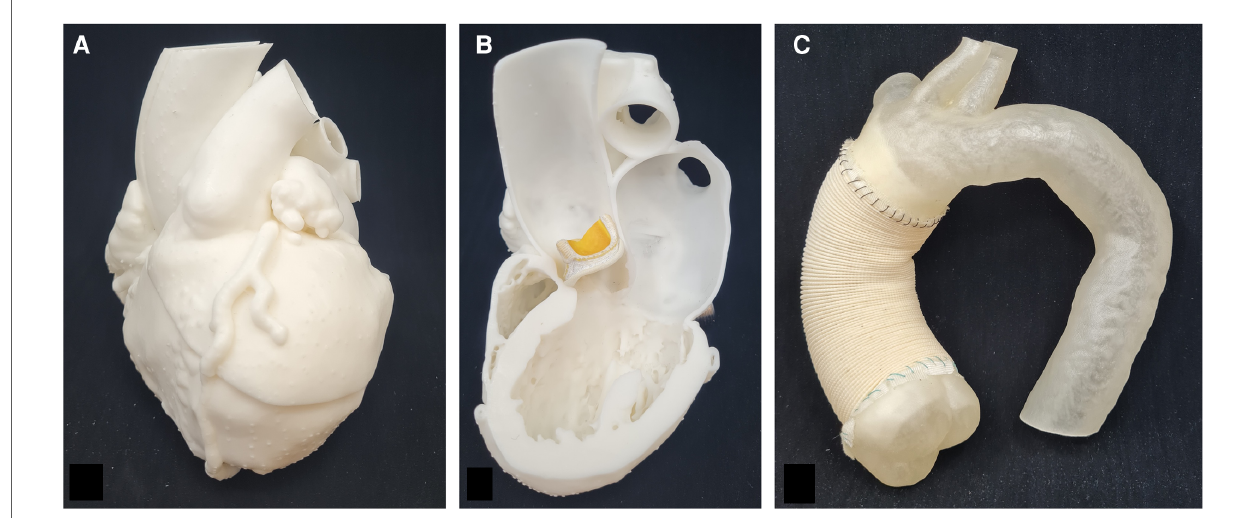
FIGURE 2 3D-printed models for CABG, SAVR and TAA . ( A ) 3D-printed model for CABG surgery to explain anatomy of coronary arteries and anastomosis of bypass grafts. ( B ) Cross-section of the left ventricle for visualization of heart valve placement. In this example, a biological heart valve prosthesis was used for better demonstration. ( C ) 3D-printed fl exible model of the aortic branch with a commercial surgical aortic graft sutured to the model for demonstration of repair of the ascending